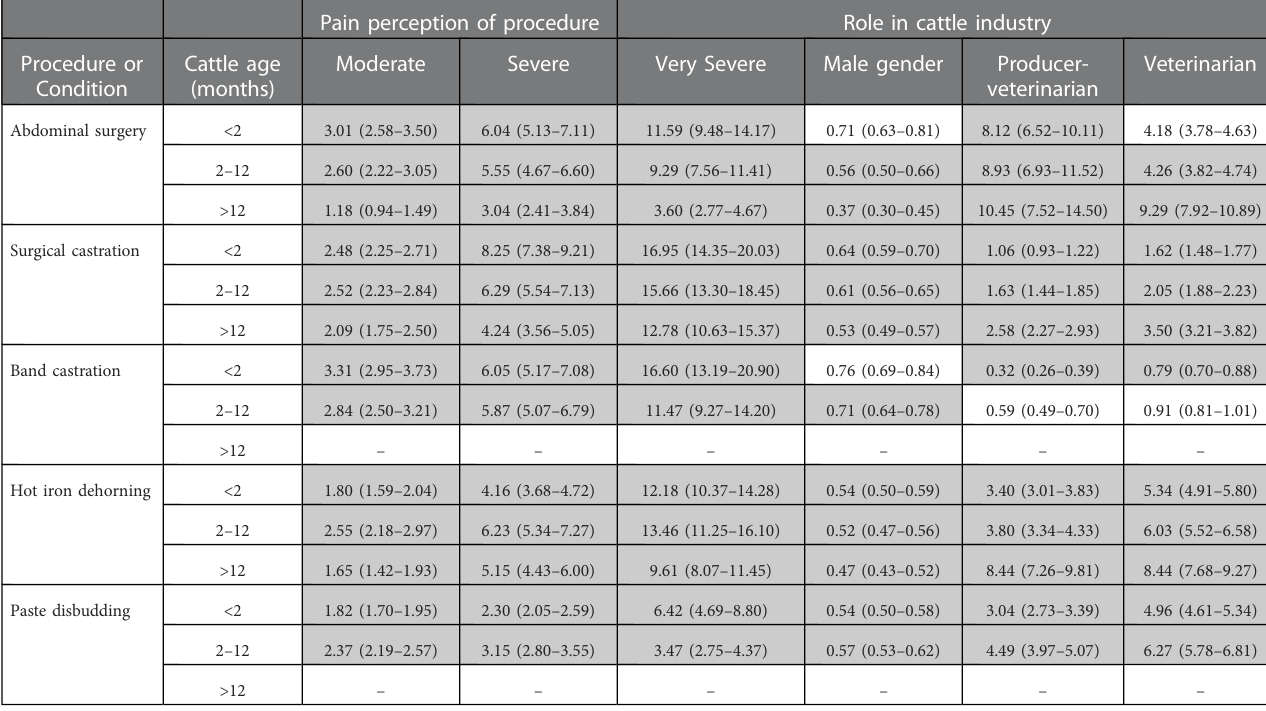
TABLE 3 Estimated odds ratios from an ordinal logistic regression model for the frequency of use of local anesthetic for multiple procedures and conditions across three cattle age categories (<2 months, 2 – 12 months, >12 months) based on perceived pain of the procedure (moderate, severe, very severe), respondent gender, and respondent role in the cattle